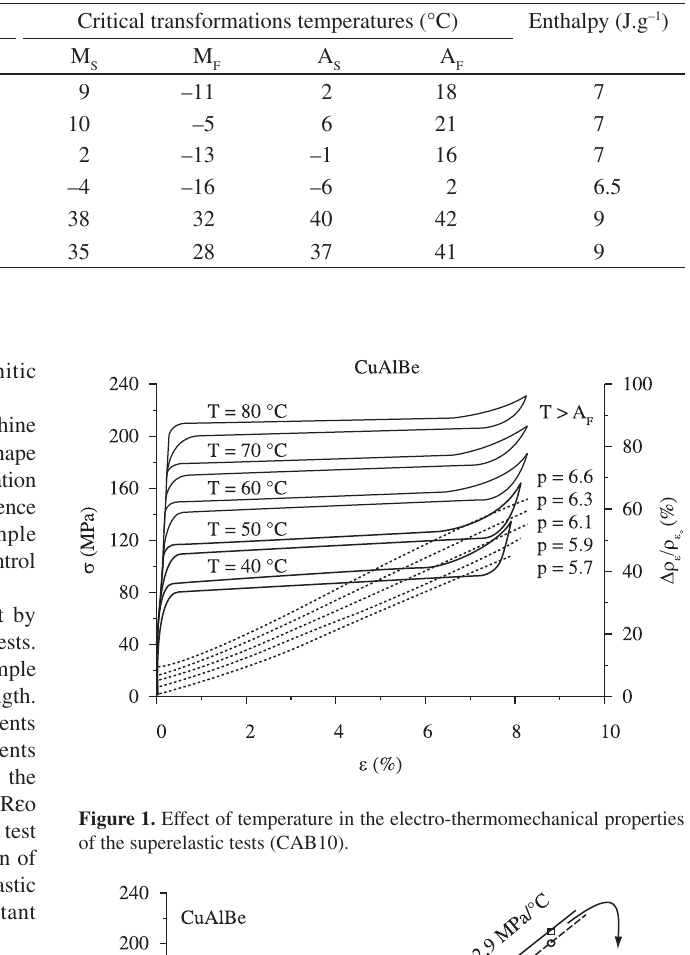
Table 1. Alloys characteristics.